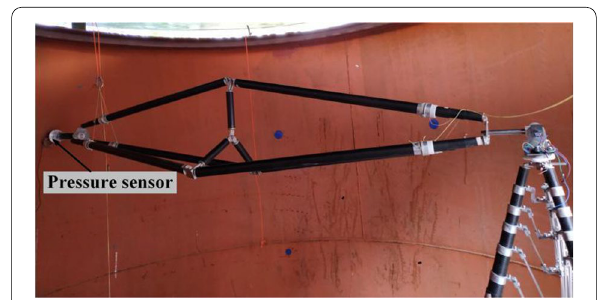
Figure 17 Result of position measurement